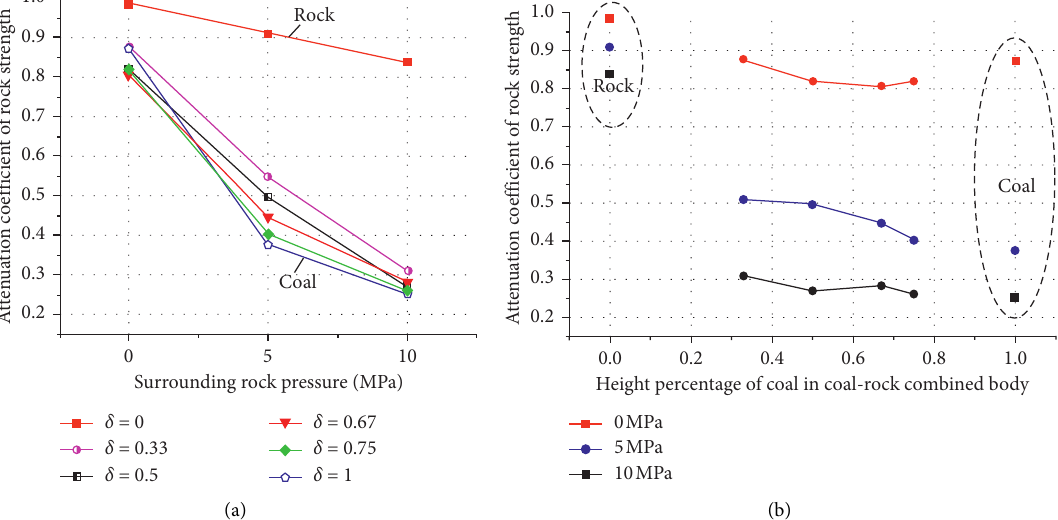
Figure 10: Variation trend of strength reduction coefficient of coal-rock combination. (a) Curve of strength reduction coefficient with confining pressure. (b) Curve of strength reduction coefficient with δ value.